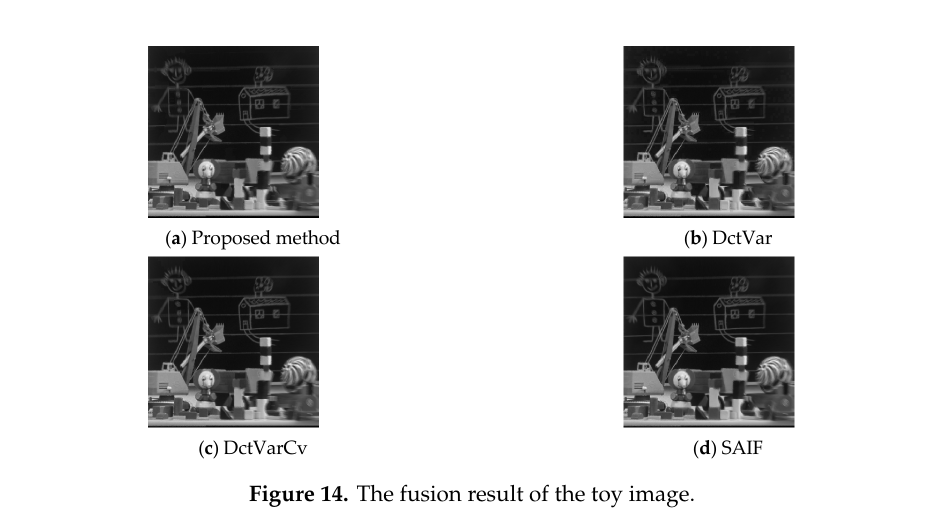
Figure 13. The fusion result of the leopard image.